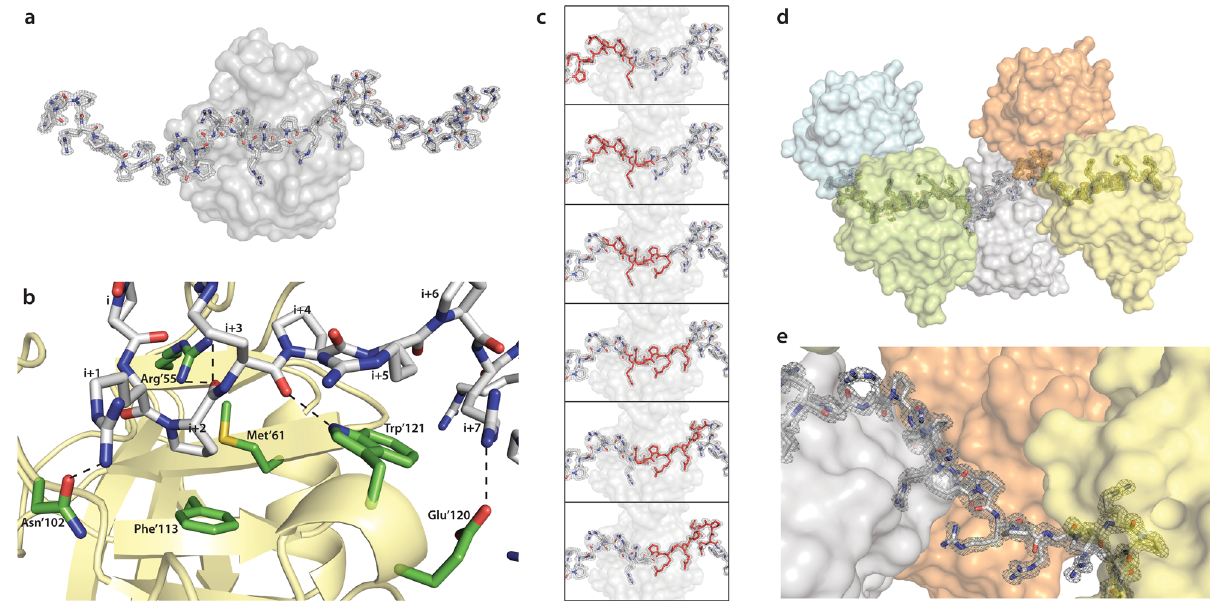
Fig. 3 Structural basis of chaperone inhibition by PR repeat polymers. a PR repeat polymer in complex with the ALS/FTD-associated prolyl isomerase PPIA. Only eight residues of the PR polymer could be built into the asymmetric unit; the displayed polymer chain was assembled from symmetry mates (2 mFo – DFc electron density map of PR20 contoured at 1.4 σ level, depicted in gray). b Close-up view of the interface between the PR repeat polymer (gray) and PPIA (yellow/green). Hydrogen bonds are depicted by dashed black lines. c The continuous electron density for the PR polymer throughout the crystal lattice allowed a slider-like positioning of its N terminus. d , e Selected regions from the crystal lattice displaying continuous electron density of the PR polymer chain (gray stick model with semi-transparent electron density). PPIA molecules are shown in surface